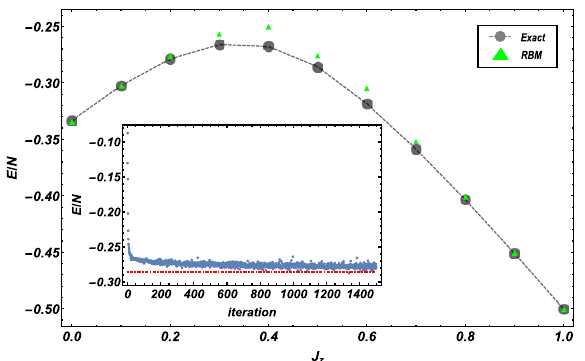
Figure 3. The ground-state energy E / N computed as a function of the coupling J z for a N = 3 × 3 × 2 lattice. RBM (green triangle) and the exact diagonalization (gray solid circle) values are compared. The inset shows the energy expectation value E / N , at the critical point J z = 0.5 , as a function of the VMC iterations. The red dashed line in the inset marks the exact value of the ground-state energy. Other parameters: J x = J y = ( 1 − J z )/ 2 , η = 0.1 , ǫ = 10 − 7 .